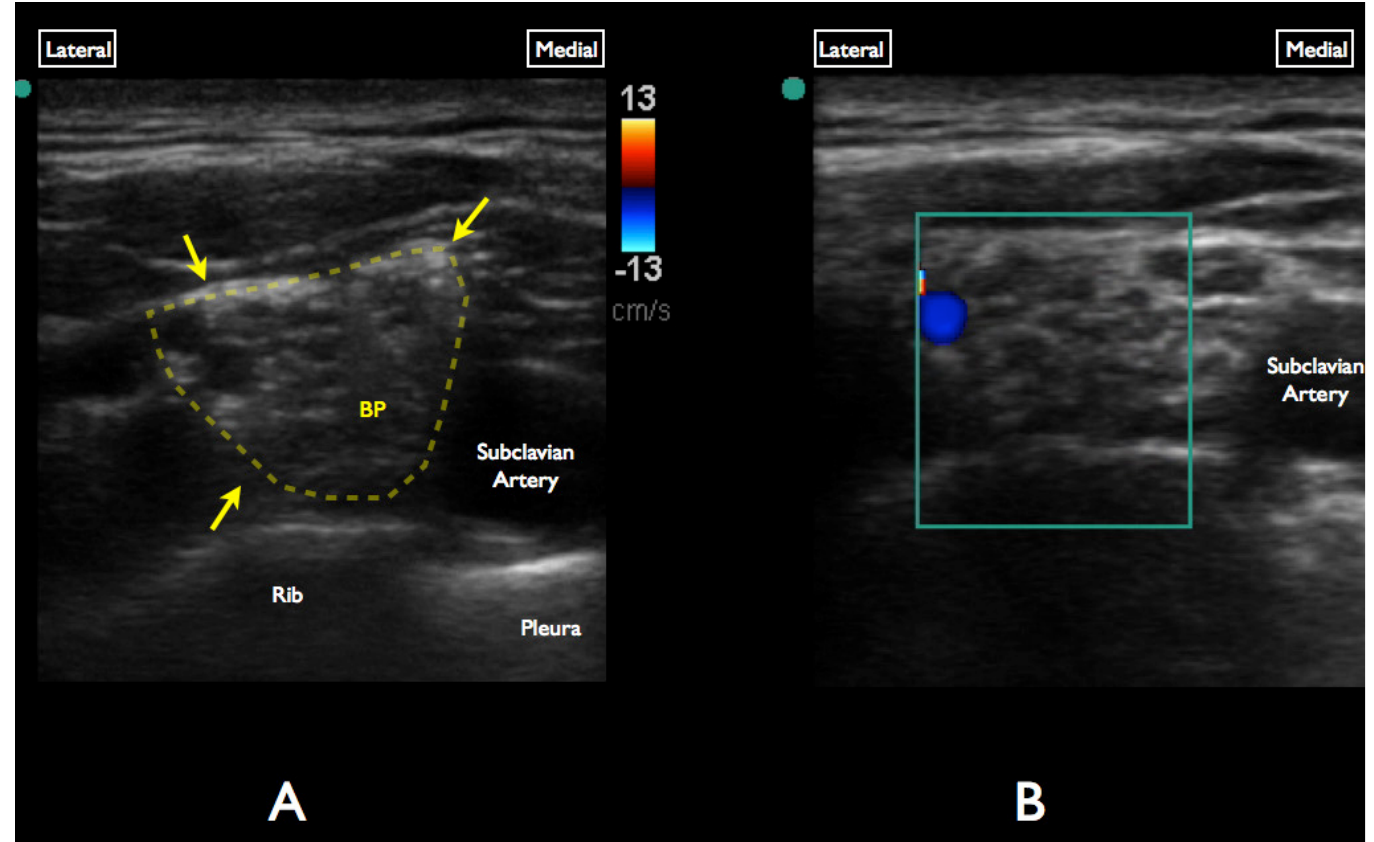
Figure 2. A, Gray-scale evaluation of the supraclavicular brachial plexus . Note the anechoic/circular nerve bundles (yellow arrows) lateral to the subclavian artery. B, Color Doppler interrogation of the brachial plexus demonstrates a vascular structure at the superolateral aspect of the brachial